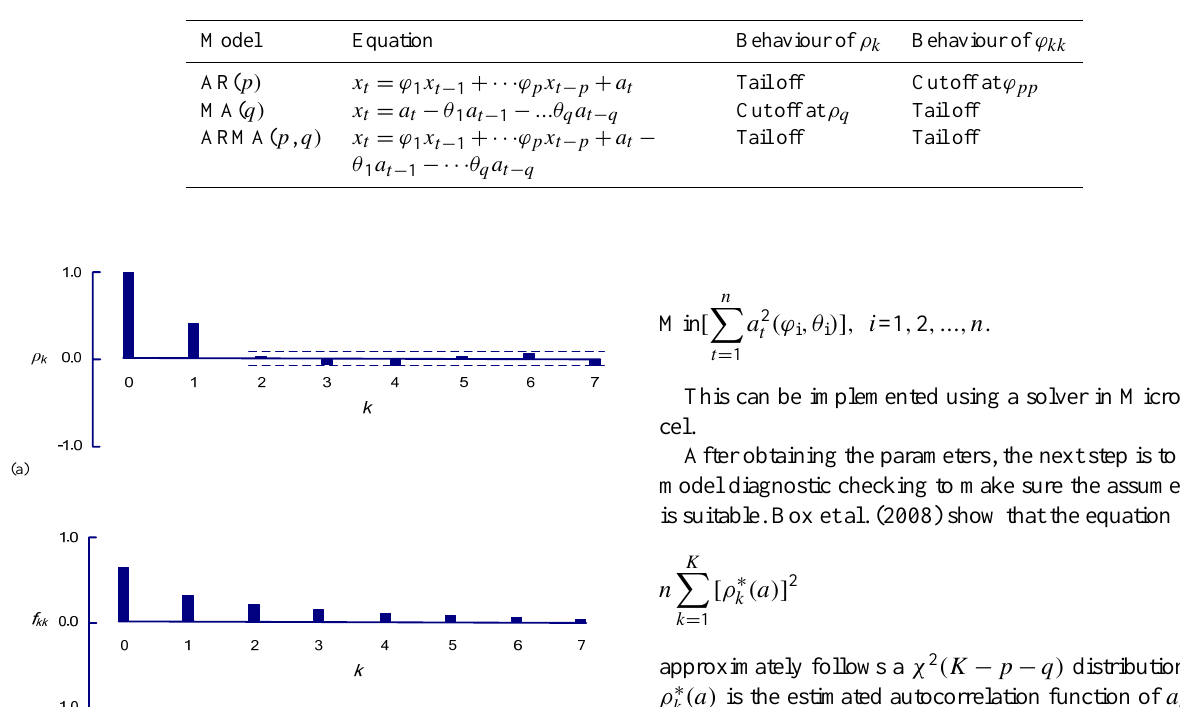
ϕ kk has a cutoff after lag p . Conversely, for MA( q ), the auto- correlation function ρ k cuts off after lag p , while its